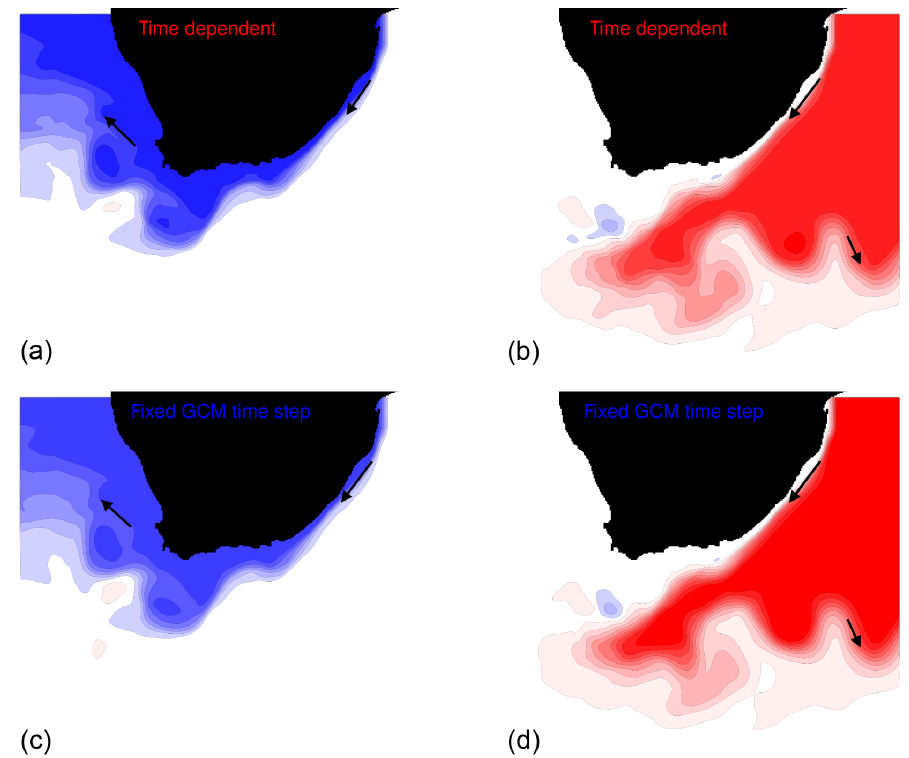
Figure 10. The Lagrangian decomposed barotropic stream function based on the particles released as previously but followed until they left the Agulhas region into the Atlantic (a, c) or the Indian Ocean (b, d) . The top panels show the time-dependent scheme and the lower panels show the fixed GCM time step scheme. Note that there is more water (one stream line extra) flowing into the Atlantic with the time-dependent scheme than with the fixed GCM time step scheme, which instead favours relatively the flow into the Indian Ocean. Stream line intervals of 8Sv ( 10 6 m 3 s − 1 ) are